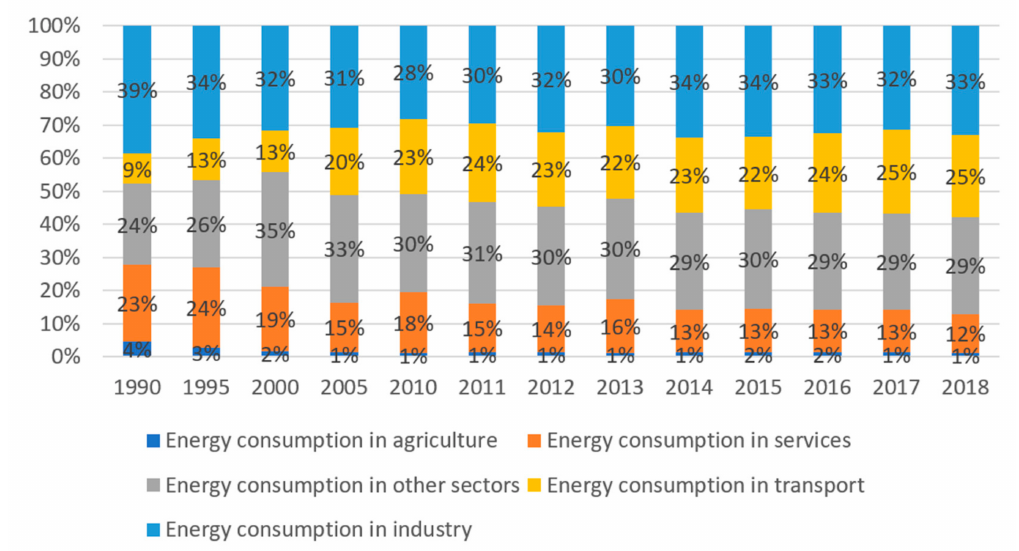
Figure 9. Structure of energy consumption in Slovakia in